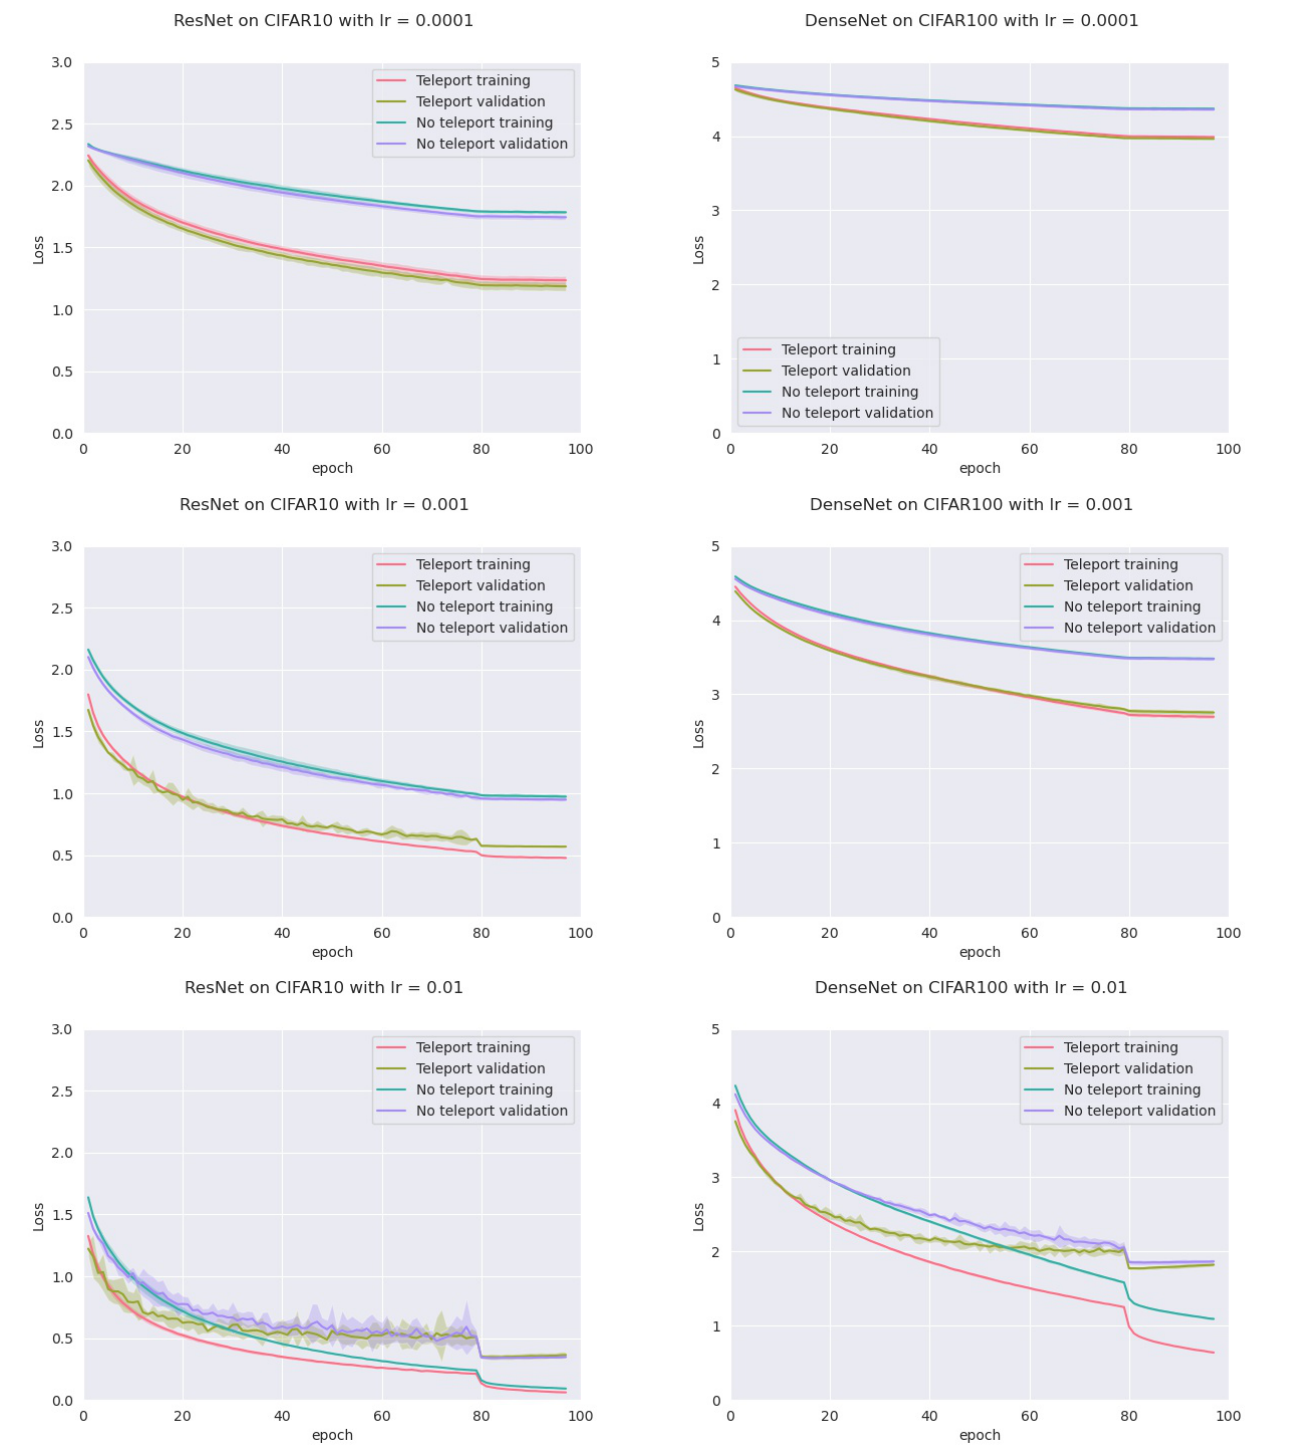
Figure A6. Average loss of ResNet on CIFAR10 ( left ) and DenseNet on CIFAR100 ( right ) over 5 experiments, with and without teleportation, at the beginning of the training with CoB of 0.9. Learning rate increases from top to bottom rows. We also show a shadow around the average curves at two times the standard deviation over the five